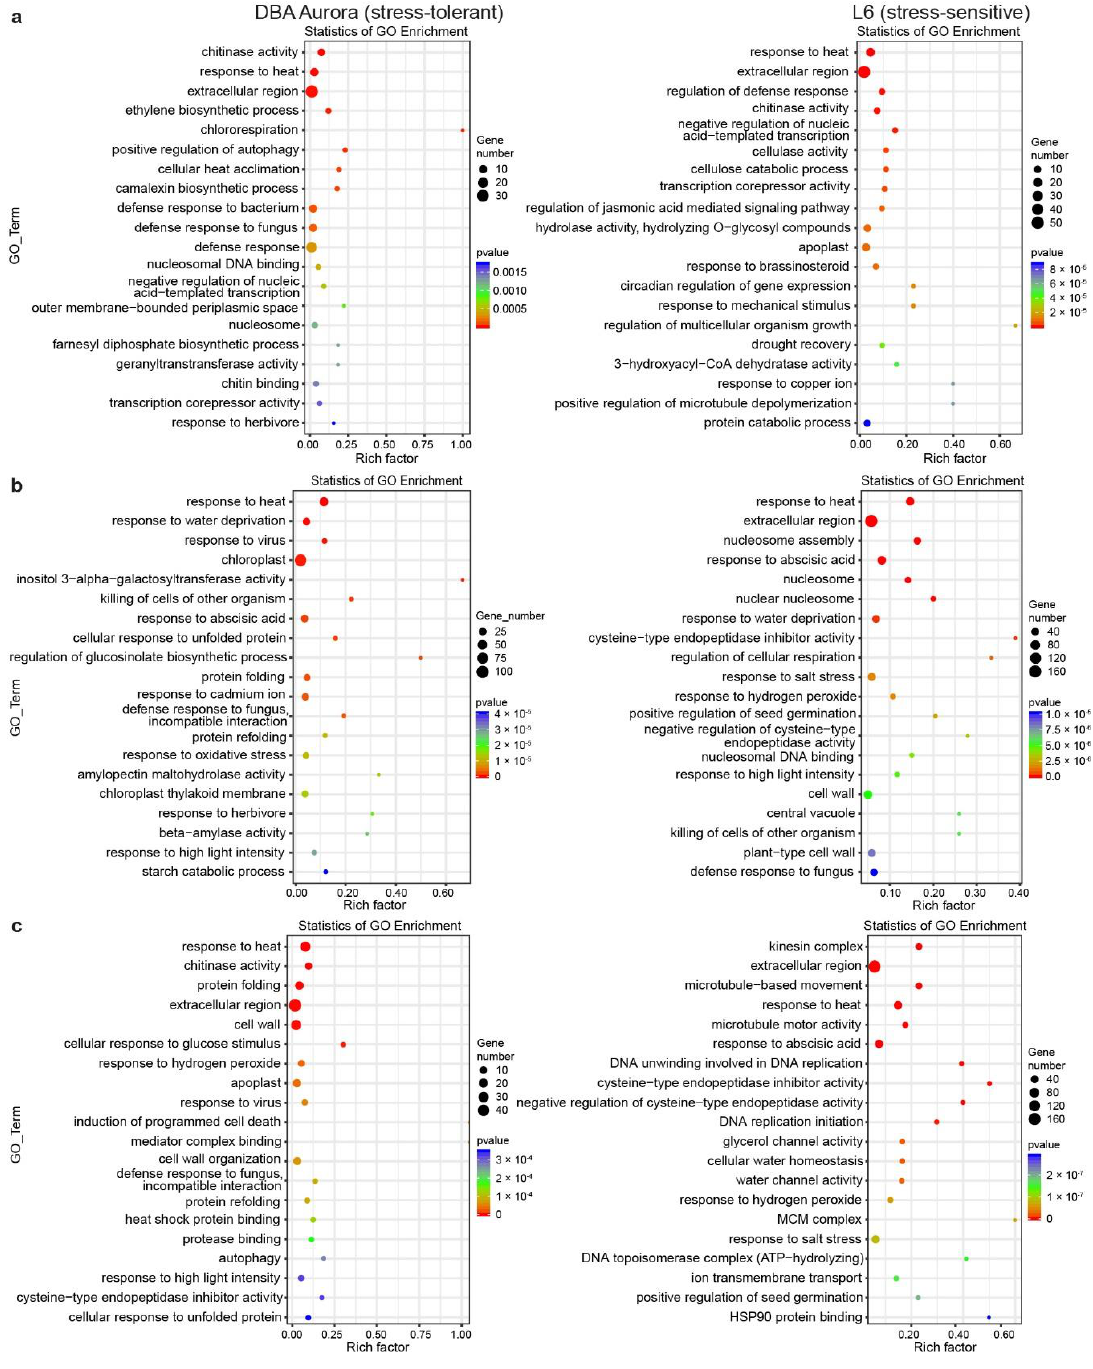
Figure 3. Enrichment analysis of the GO (Gene Ontology) terms for stress-responsive genes identified under each type of stress treatment. ( a ) GO analysis of genes responsive to single water deficit stress. ( b ) GO analysis of genes responsive to single heat stress. ( c ) GO analysis of genes responsive to water deficit stress plus heat stress. The rich factor represents the proportion of stress-responsive genes within all the genes under a certain GO term (higher rich factor indicates higher level of enrichment).